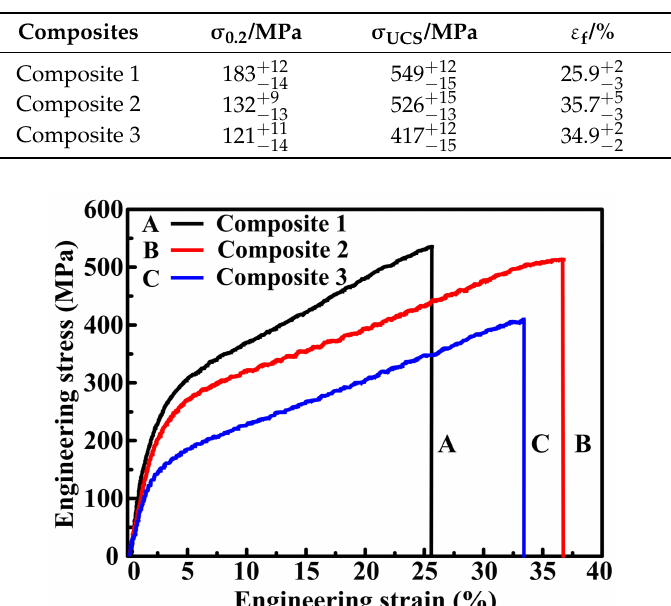
Figure 5. Compression engineering stress–strain curves of composites 1, 2, and